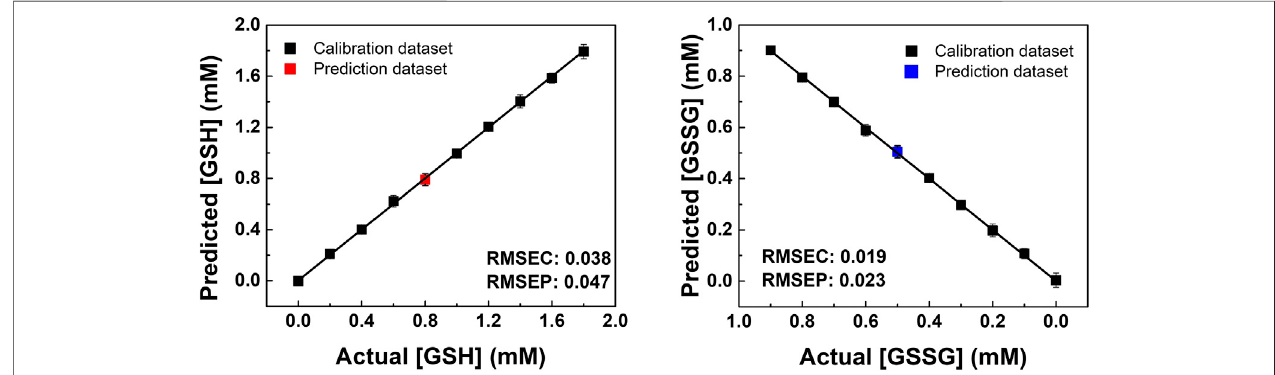
FIGURE 4 | SVM regression analysis for quantitative analysis of the GSH and GSSG mixtures in various concentration ratios. The RMSEC and RMSEP values (shown as insets) represent the accuracy of the constructed model and the prediction.